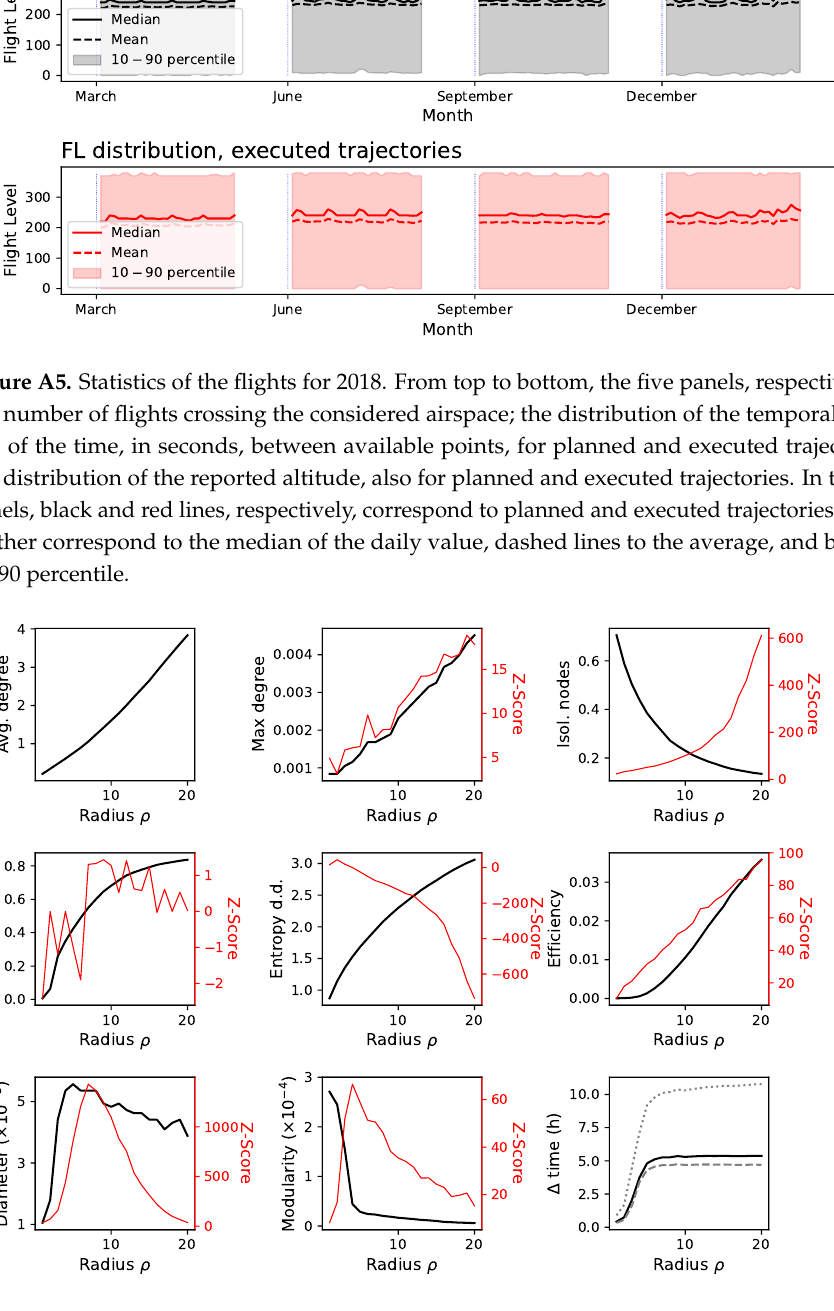
Figure A6. Properties of the interaction networks, for the planned trajectories of 1 September 2018, as a function of the interaction radius ρ . Black (left Y axes) and red lines (right Y axes), respectively, correspond to the raw values and their